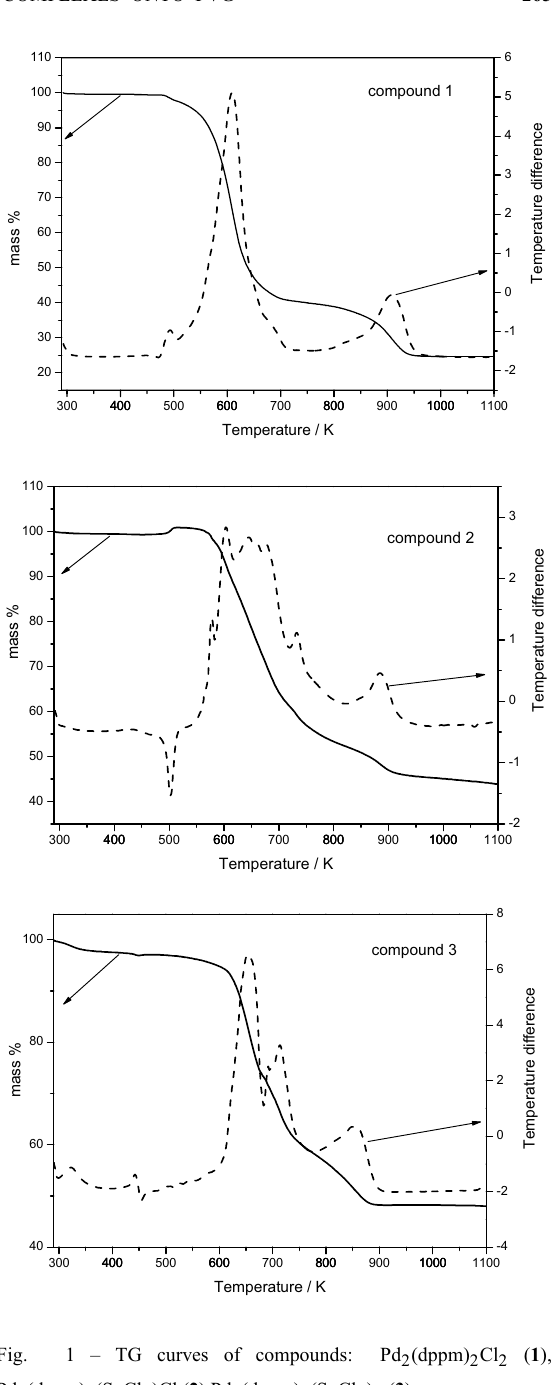
Fig. 1 – TG curves of compounds: Pd 2 (dppm) 2 Cl 2 ( 1 ), Pd 2 (dppm) 2 (SnCl 3 )Cl ( 2 ) Pd 2 (dppm) 2 (SnCl 3 ) 2 ( 3 ).